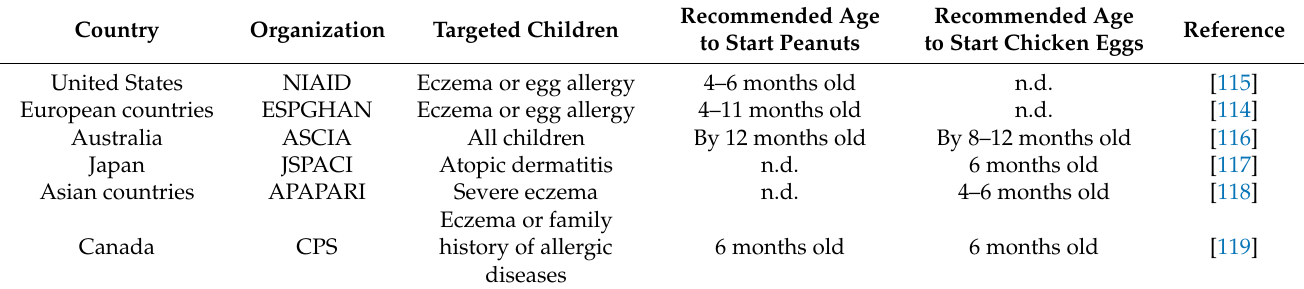
Abbreviations: NIAID, National Institute of Allergy and Infectious Diseases; ESPGHAN, European Society for Paediatric Gastroenterology Hepatology and Nutrition; ASCIA, Australasian Society of Clinical Immunology and Allergy; JSPACI, Japanese Society of Pediatric Allergy and Clinical Immunology; CPS, Canadian Pediatric Society; n.d: not